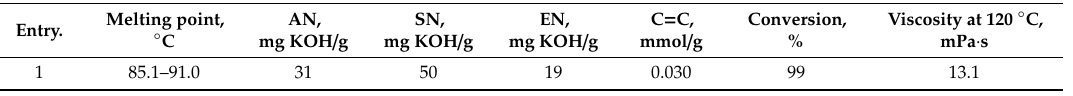
Table 5. Properties of pre-oxidized with H 2 O 2 raw material used in the oxidation reaction using oxygen. Entry.